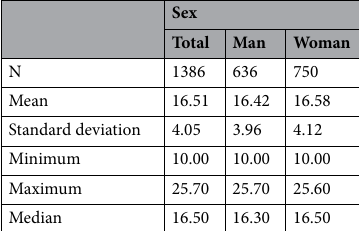
Table 2. Age (years) according to sex.